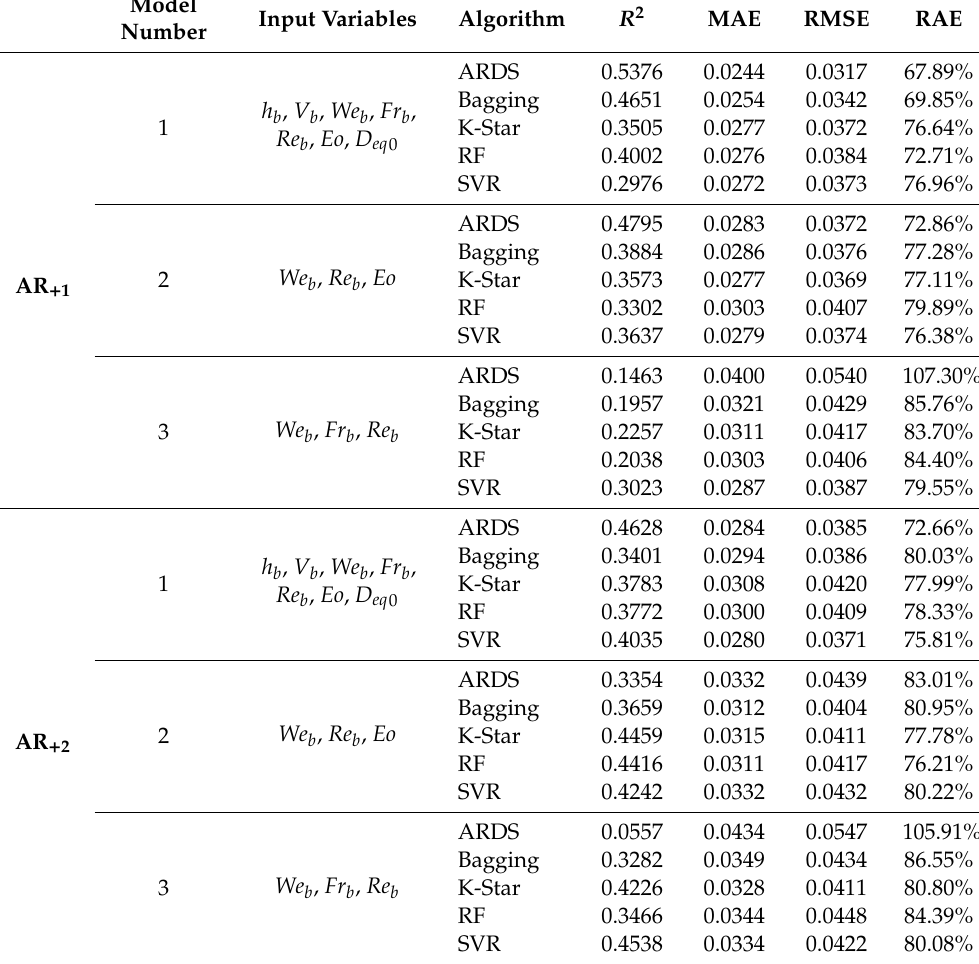
Table 2. Synthesis of the results of aspect ratio (AR) prediction